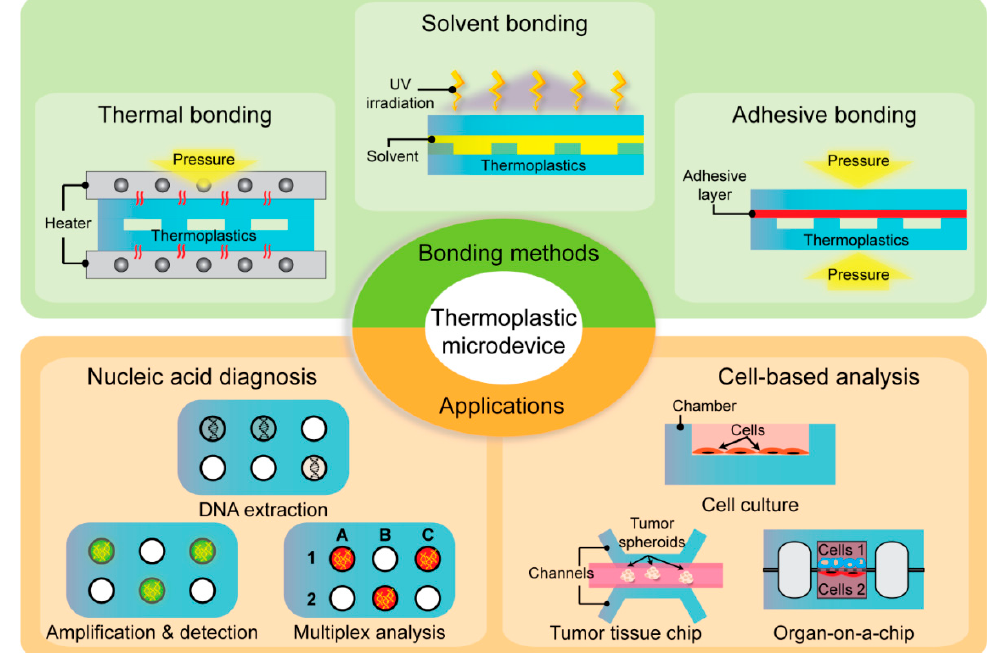
Figure 1. Summary of representative bonding methods (thermal bonding, solvent bonding, and adhesive bonding) and the applications of thermoplastic microfluidics in nucleic acid diagnosis and cell ‐ based analysis.